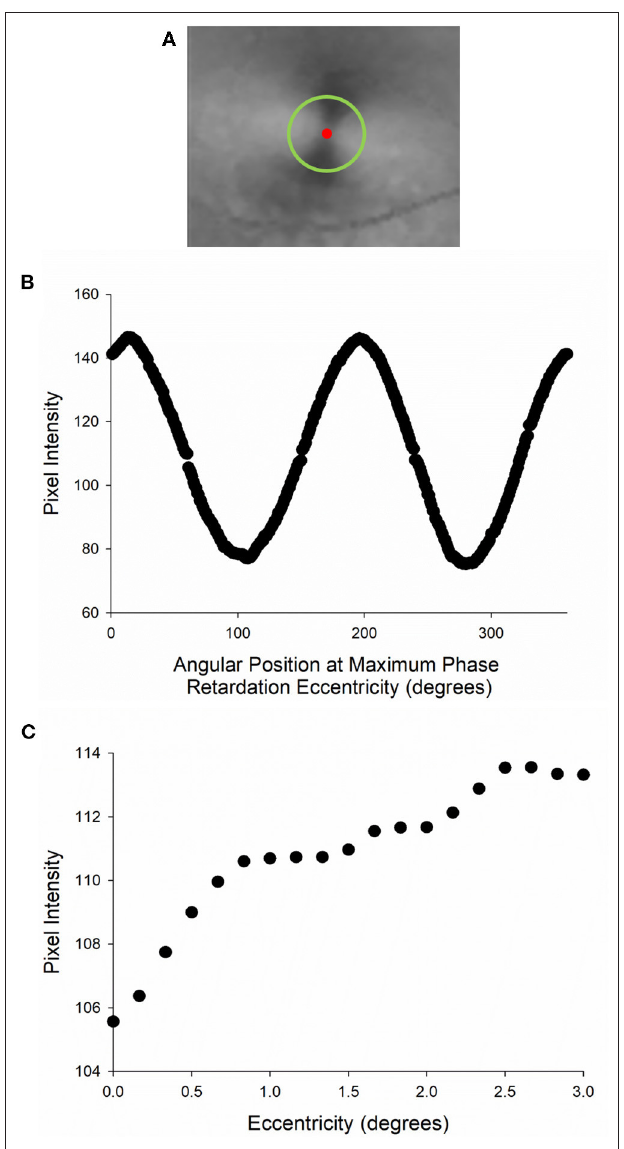
FIGURE 4 | Analysis of phase retardation distribution map. (A) Center of macular cross (red circle) with a circular region of interest (green circle). (B) Pixel intensity profile along the circular region of interest. (C) The amplitude of pixel intensity was used as a relative measure of phase retardation and plotted as a function of